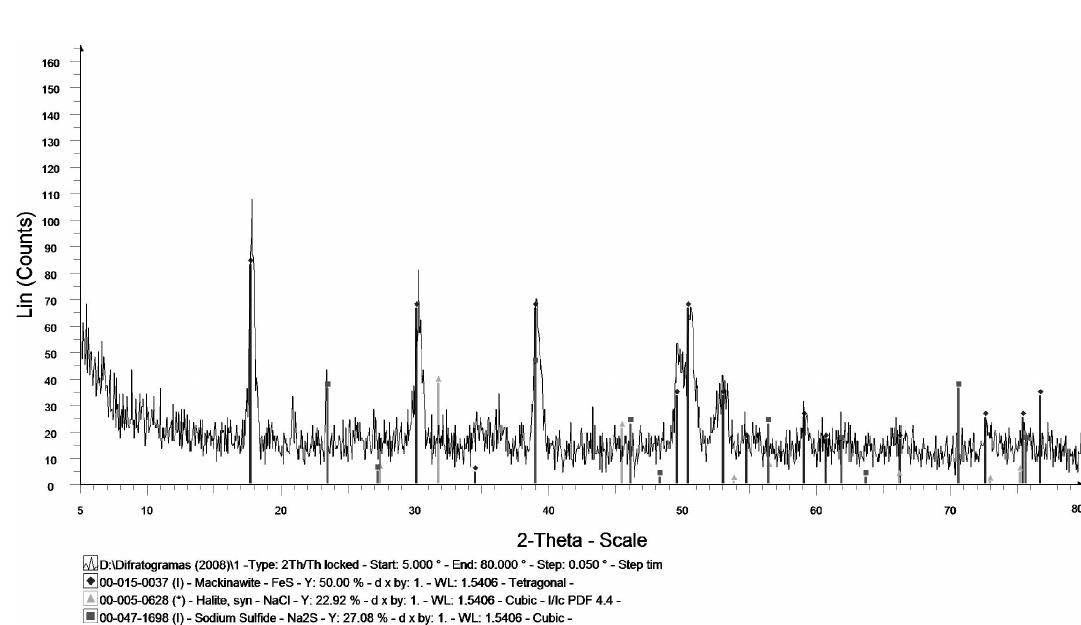
Figure 9. XRD spectrum of the corrosion product film of the welded joint tested in solution 2,